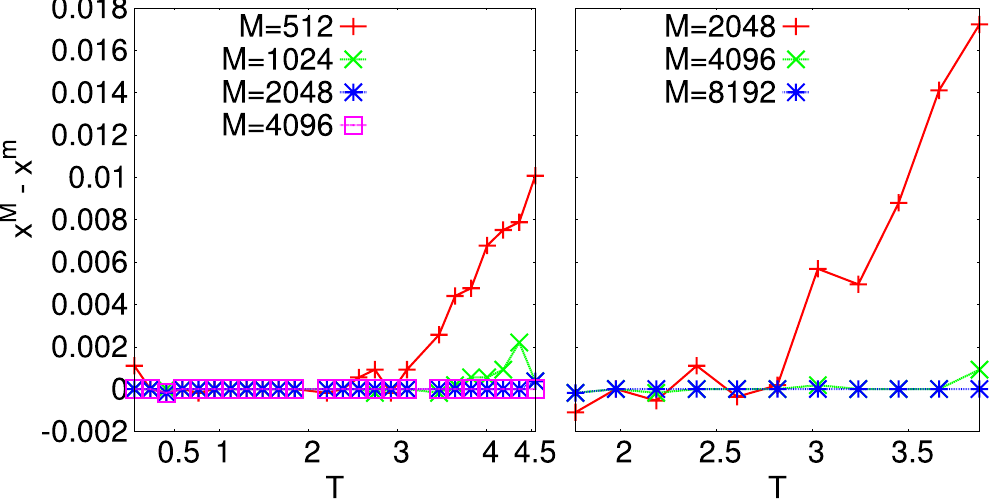
Figure 5. Plot of the difference between the maximum point of  , x M , and the minimum point of the t reconstruction error, x m , vs T at different M for systems of N = 16 variables. Left: 4- XY model on sparse Mode- locked graph with N q = 47 ( .  T (16) 0 50 ). Right: 4SM model on dense Mode-Locked graph with N q = 252 c ( .  T